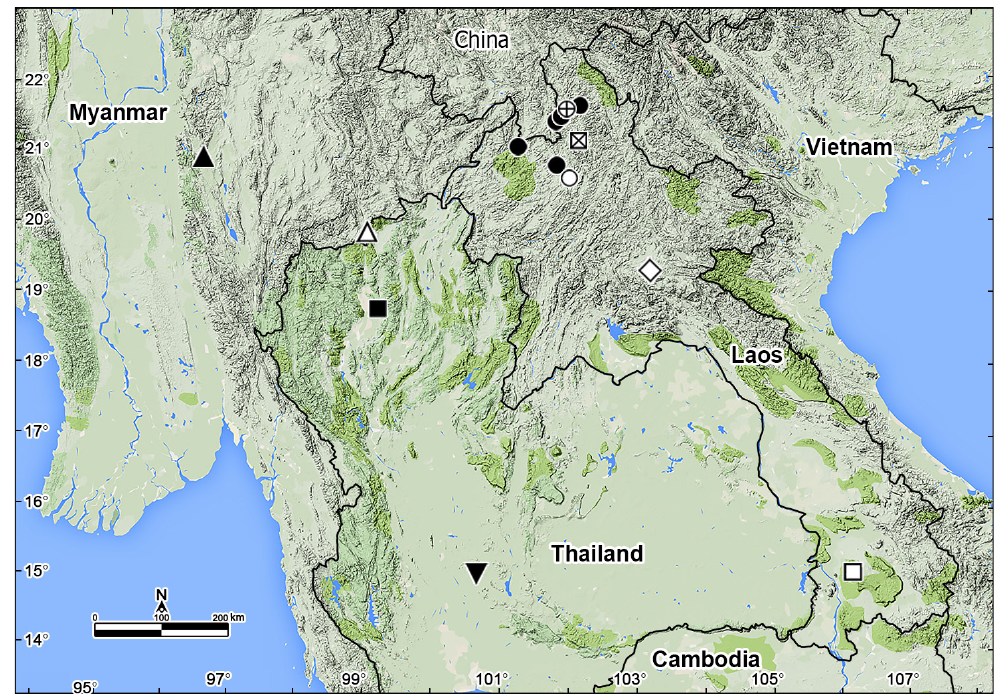
Fig. 26. Distribution of the new eight species of Tylopus . Filled triangle . T. punctus sp. nov. Filled circle . T. acuminatus sp. nov. Crossed circle . T. acuminatus sp. nov., T. dorsalis sp. nov. Crossed square . T. acuminatus sp. nov. T. retusus sp. nov. Open circle . T. retusus sp. nov. Open triangle . T. baenzigeri Golovatch & Enghoff, 1993. Filled square . T. hongkhraiensis sp. nov. Open diamond . T. thunghaihin sp. nov. Inverted filled triangle . T. flavolineatus sp. nov. Open square . T. moniliformis sp.